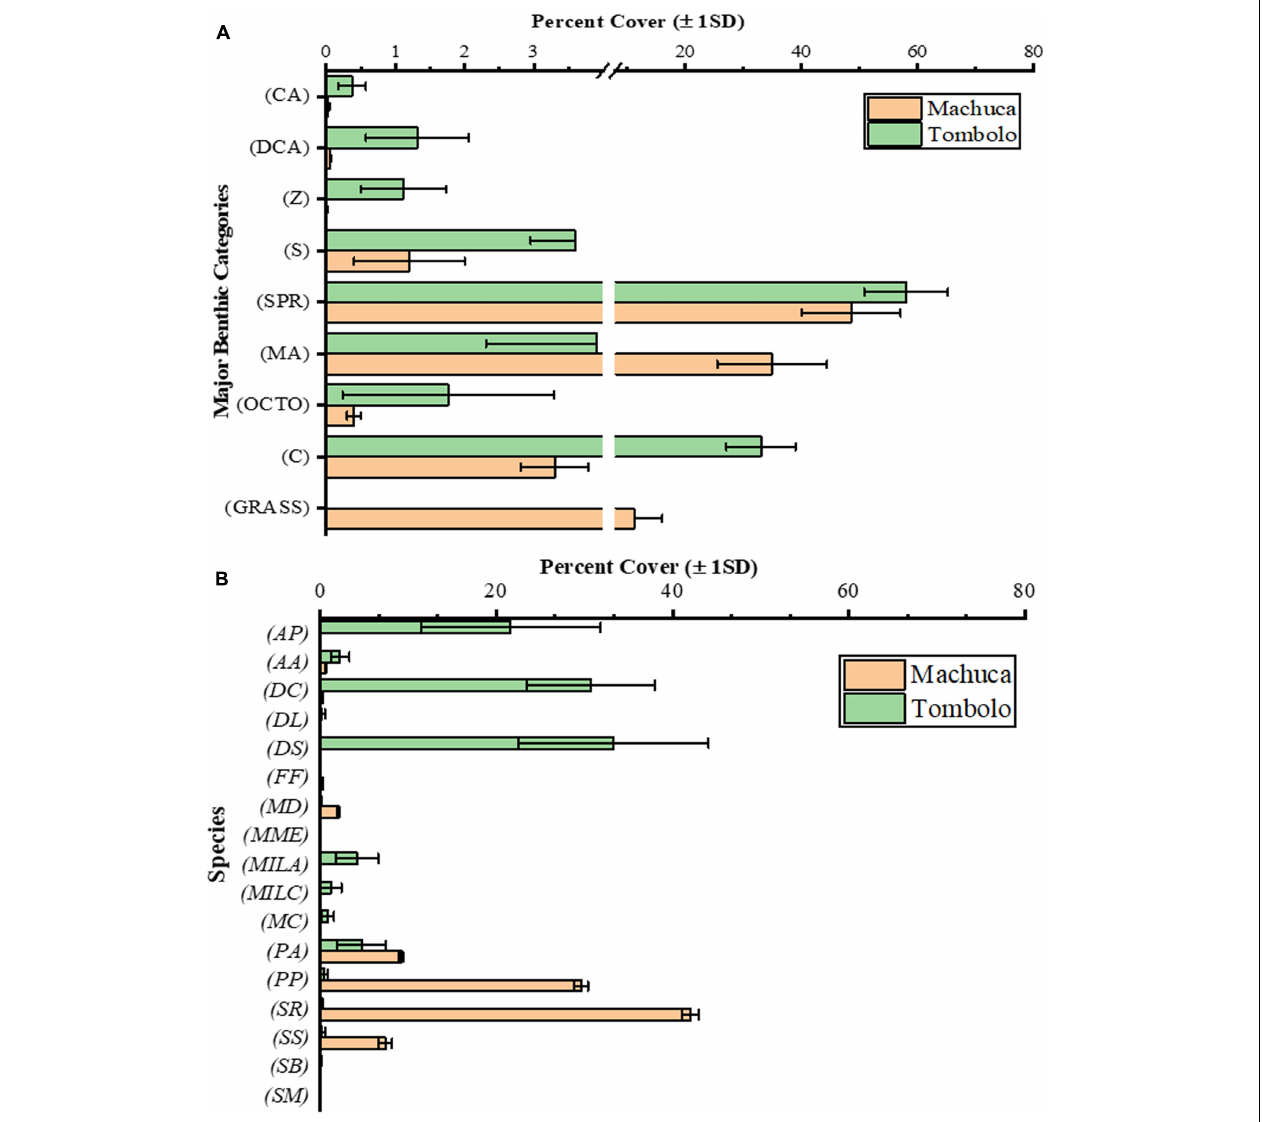
FIGURE 6 | (A) Percent cover of major categories ( ± 1 SD) of benthic substrates at both study sites. Categories abbreviations: Scleractinian Corals (C), Macroalgae (MA), Seagrasses (GRASS), Octocorals (G), Sponges (S), Zoanthids (Z), Coralline Algae (CA), and Sand, Pavement, and Rubble (SPR). (B) Distribution of Scleractinian and Milleporid species (by percentage ± 1 SD) at both study sites. Total Scleractinian cover at Tómbolo Reef averaged 33% ( ± 5.96) and at Machuca Reef averaged 3.3% ( ± 0.48). The graphs show the breakdown by species of that percentage. Species abbreviations: Acropora palmata (AP), Agaricia agaricites (AA), Pseudodiploria clivosa (DC), Diploria labyrinthiformis (DL), Pseudodiploria strigosa (DS), Favia fragum (FF), Madracis decactis (MD), Meandrina meandrites (MME), Millepora alcicornis (MILA), Millepora complanata (MILC), Montastraea cavernosa (MC), Porites astreoides (PA), Porites porites (PP), Siderastrea radians (SR), Siderastrea siderea (SS), Solenastrea bournoni (SB), and Stephanocoenia michelini